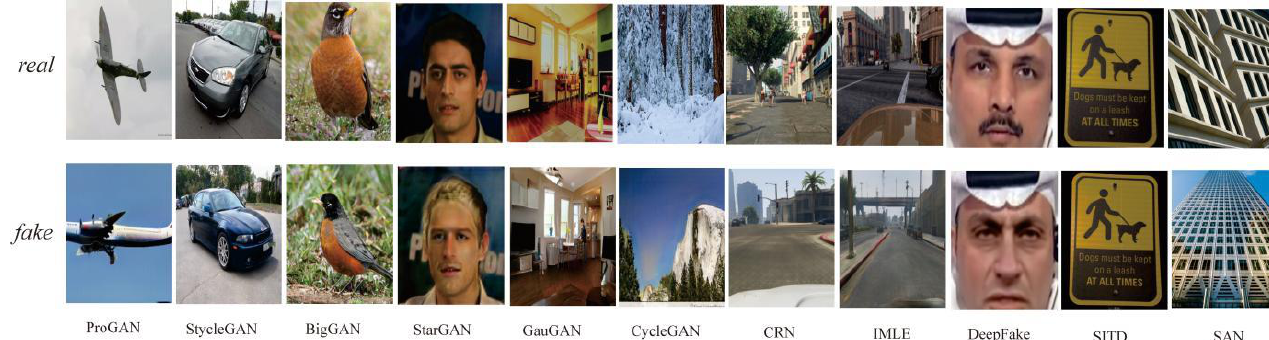
Figure 1. Examples of real and fake images generated by eleven CNN generation models (ProGAN, StyleGAN, Big-GAN, CycleGAN, StarGAN, GauGAN, DeepFakes, cascaded refinement networks (CRN), implicit maximum likelihood estimation (IMLE), second-order attention, seeing-in-the-dark (SITD)) super-resolution